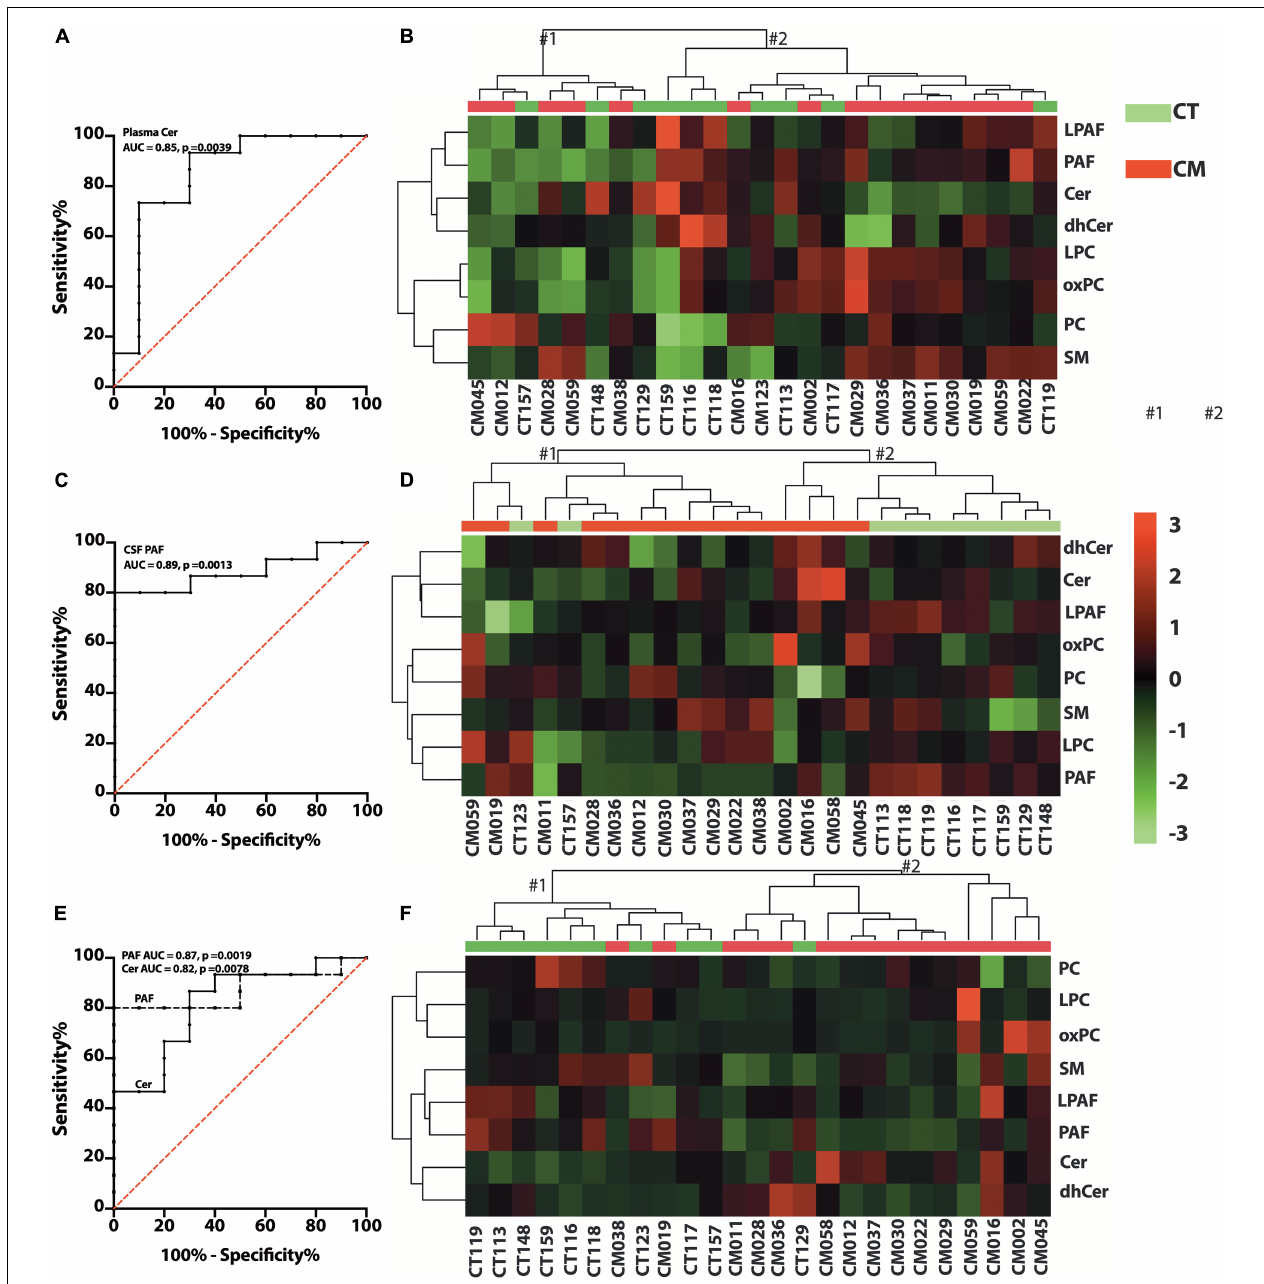
FIGURE 6 | Glycerophospholipid (GP) and SP changes in CT versus CM. (A) ROC curve of plasma Cer. (B) Heat map of the hierarchical clustering of plasma GPs (LPAF, PAF, LPC, and PC) and SPs (SM, Cer, and dhCer). We used Euclidean for distance measure and Ward for the clustering algorithm for the heatmap. (C) ROC curve of CSF PAF. (D) Heat map of the hierarchical cluster of CSF GPs and SPs. The distance measure and clustering algorithm for the heatmap used Euclidean for Ward, respectively. (E) ROC curve of CSF/plasma of Cer and PAF. (F) Heat map of the hierarchical clustering of CSF/plasma ratio of GPs and SPs using Euclidean for distance measure and Ward for the clustering